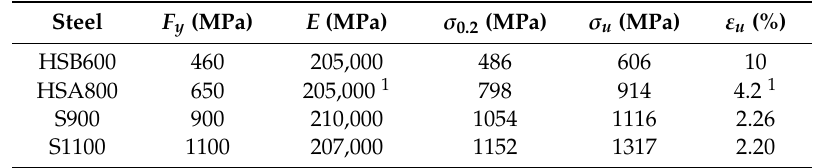
Table 6. Material properties for parametric study.